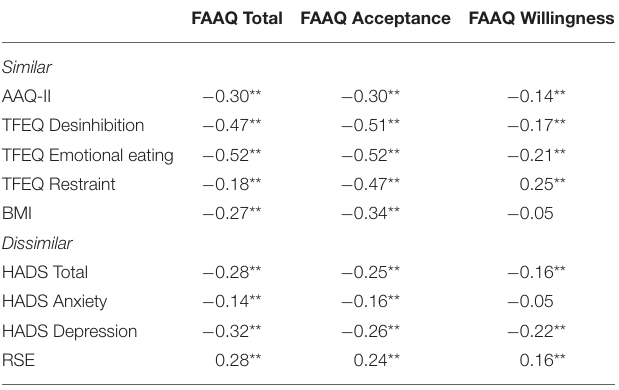
TABLE 4 | Correlations between the FAAQ and other